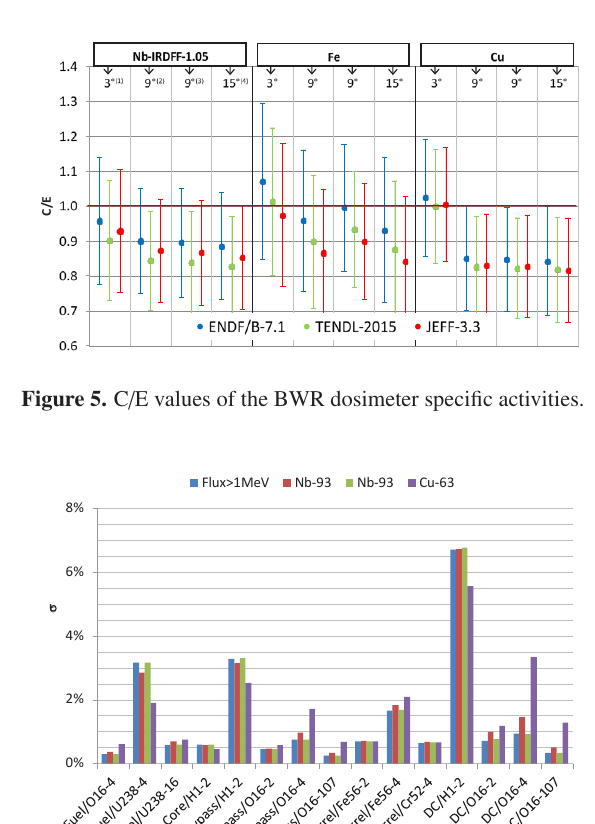
Figure 6. Main uncertainty contributors for the BWR RPV dosimetry